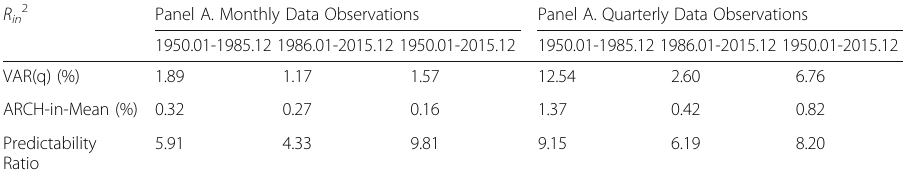
Table 8 In-Sample R -squares Reported by VAR( q ) and ARCH-in-Mean over Different Time Horizons R in 2 Panel A. Monthly Data Observations Panel A. Quarterly Data